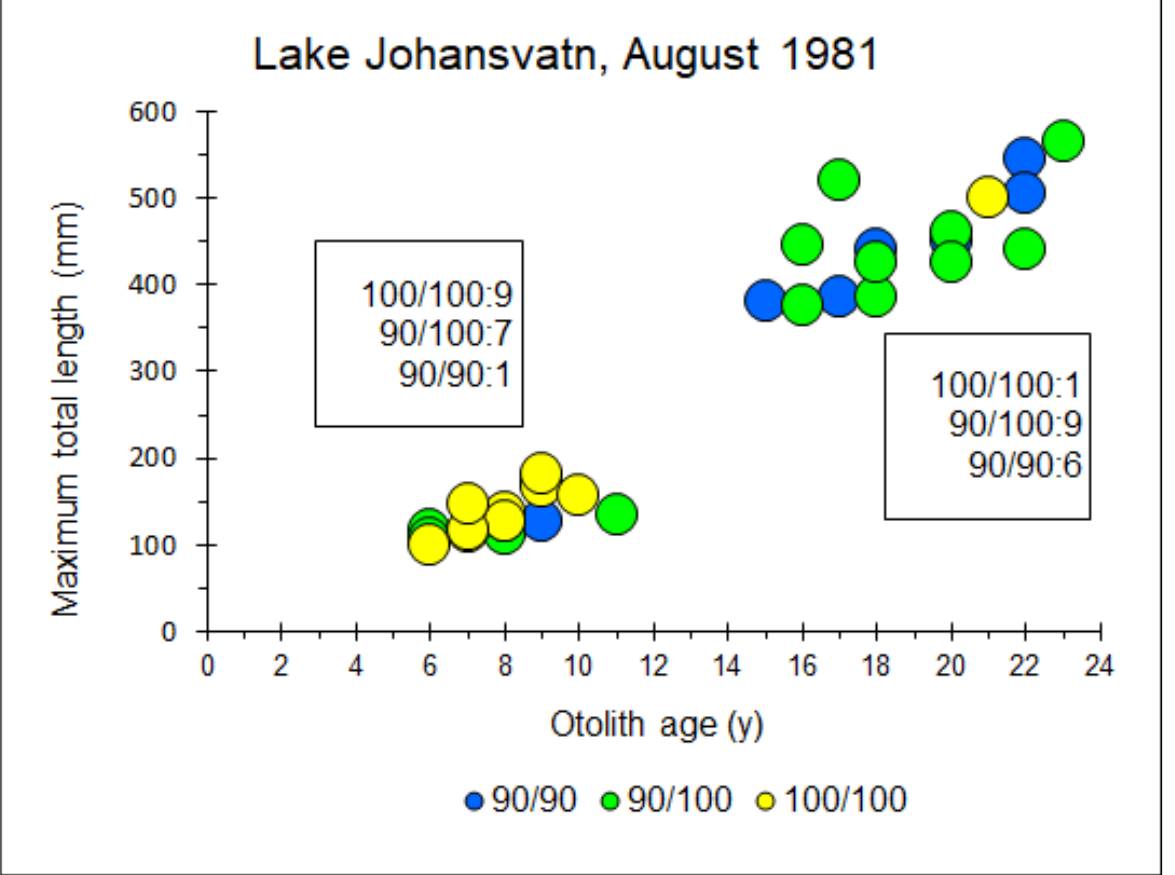
Figure 6. EST-2* genotype designation and length by otolith age correlations in two modal groups of landlocked Arctic char sampled in Lake Johansvatn, Danskøya, Svalbard, 20–21 August 1981.